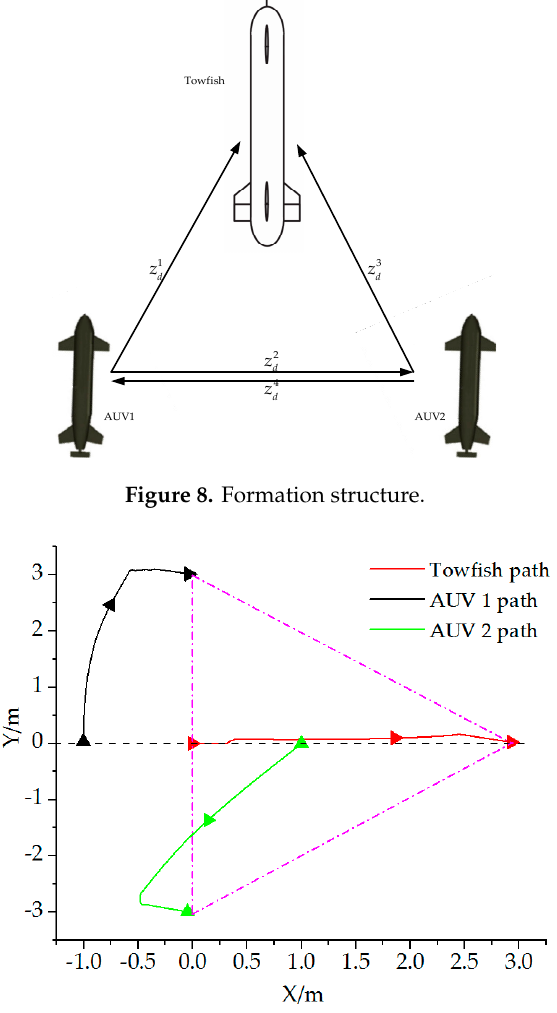
Figure 9. Vehicle paths while forming formation.